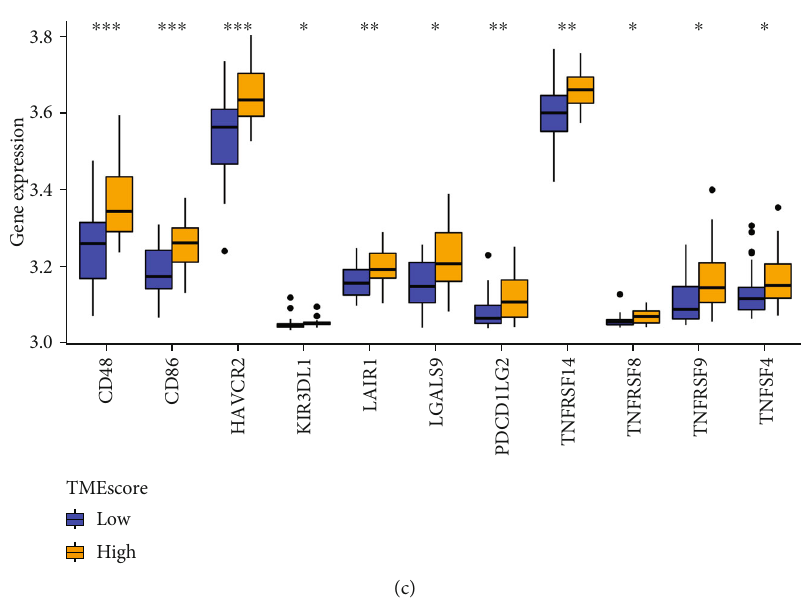
Figure 7: Potential immune escape mechanisms associated with the TMEscore. (a) Immune exclusion score in high and low TMEscore. (b) Expression of immune checkpoints was higher in the high-TMEscore group relative to the low-TMEscore group in TCGA cohort. (c) Immune checkpoint expression was validated using dataset